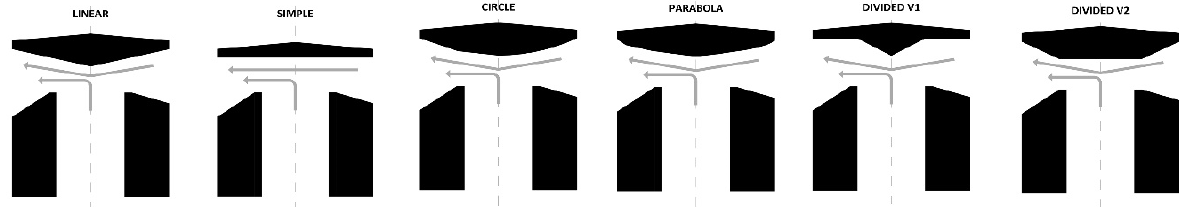
Figure 13. Next step of optimization a PACS- multiple geometry scenarios for partial development.